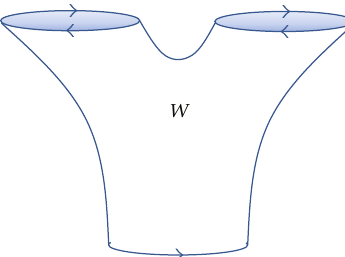
Figure 2: Surface W carries the trivial rank 1 complex vector bundle on it and serves as a bordism between (cid:3) and two copies of (cid:2) S 1 ,(cid:8) 1 ,f (cid:2) − S 1 ,(cid:8) 1 ,f 1